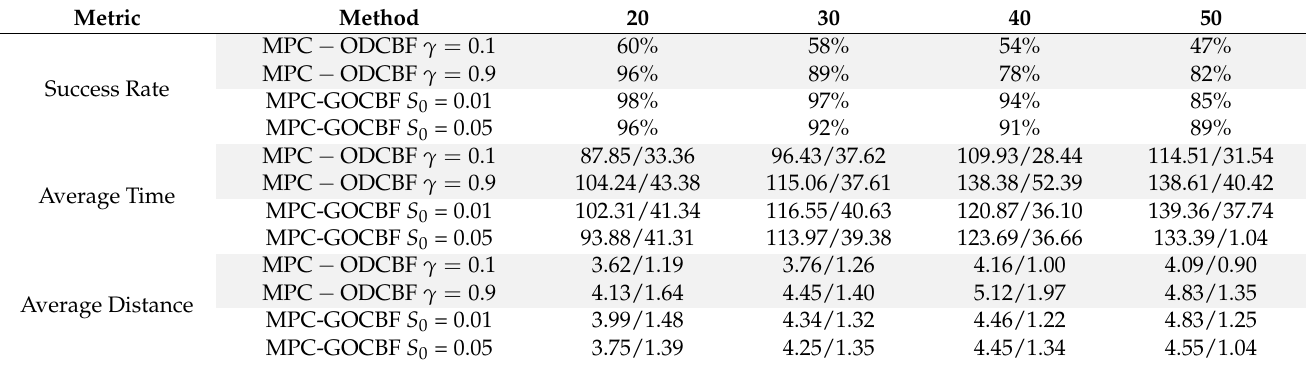
Different Numbers of